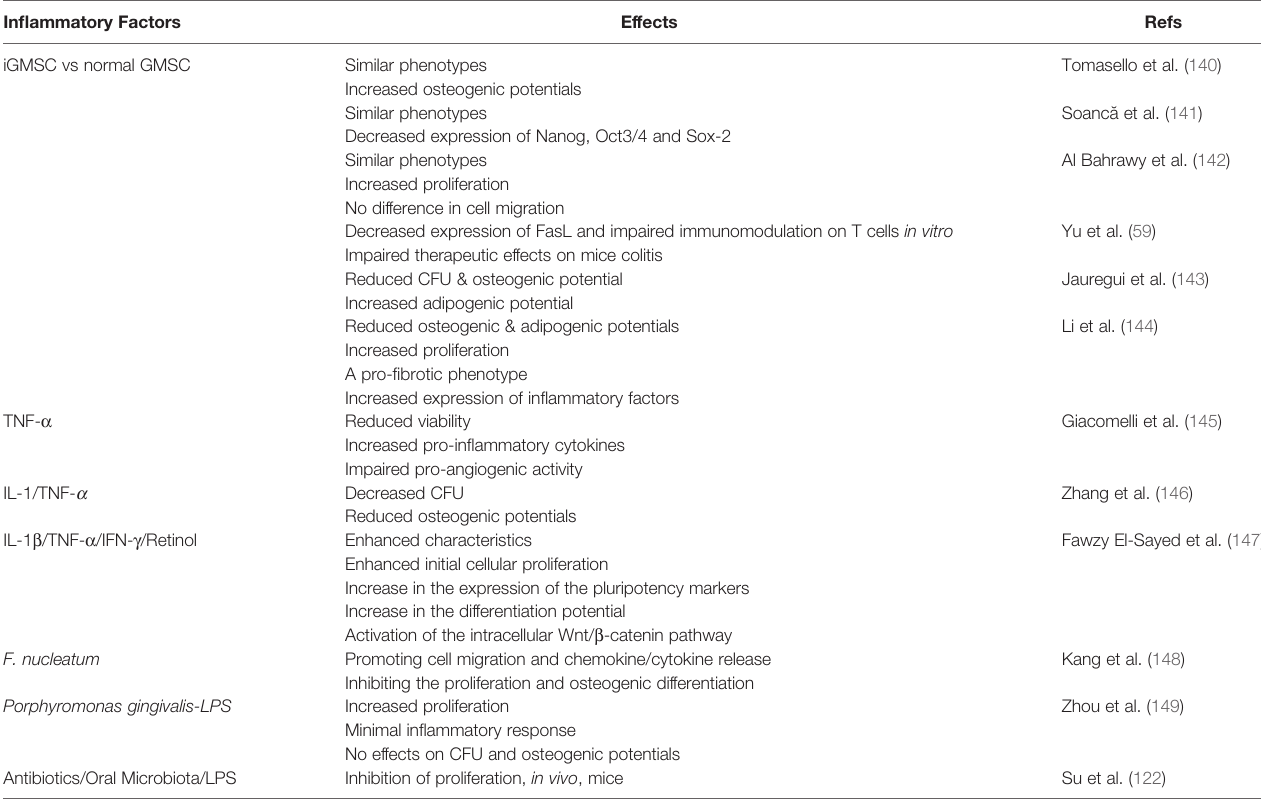
TABLE 8 | Effects of bacteria/in fl ammation on the property and function of GMSCs. In fl ammatory